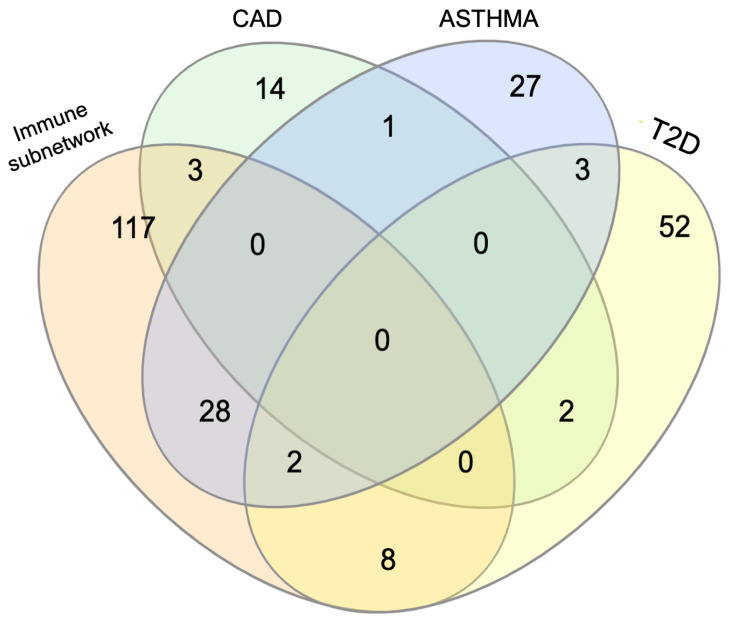
Venn diagram of the overlap between the COVID-19 immune subnetwork and comorbidities’ subnetworks, with the respective number of genes.T2D: Type 2 Diabetes; CAD: Coronary Artery Disease.